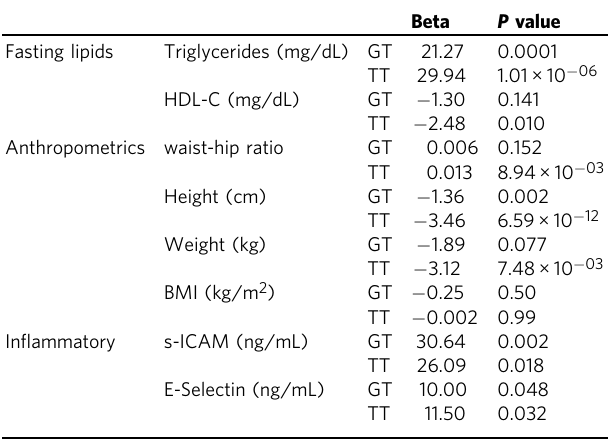
Table 2 Genotypic effects of rs174537 on fasting lipids, anthropometrics and in fl ammatory